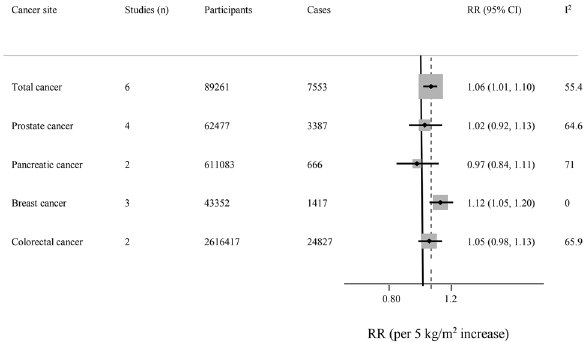
Figure 2. Summary risk estimates of overall and different cancer sites for each 5-unit increase in body mass index in patients with T2D.